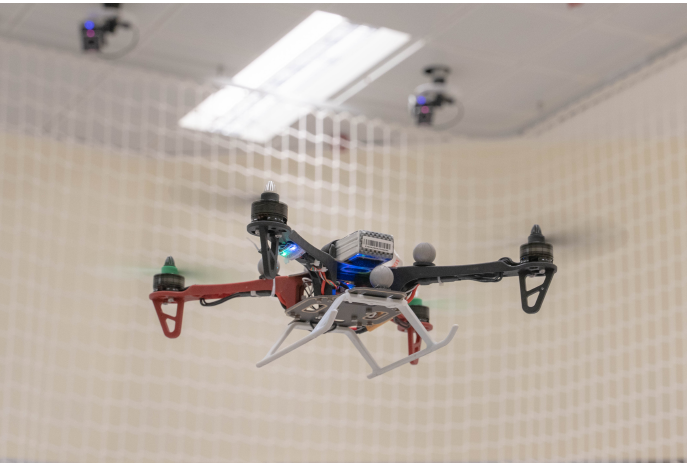
Figure 9. F330 quadrotor UAV used for flight